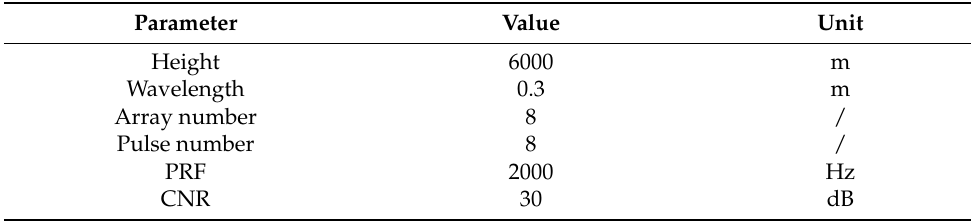
Table 1. Parameters used in the experiment scenarios.